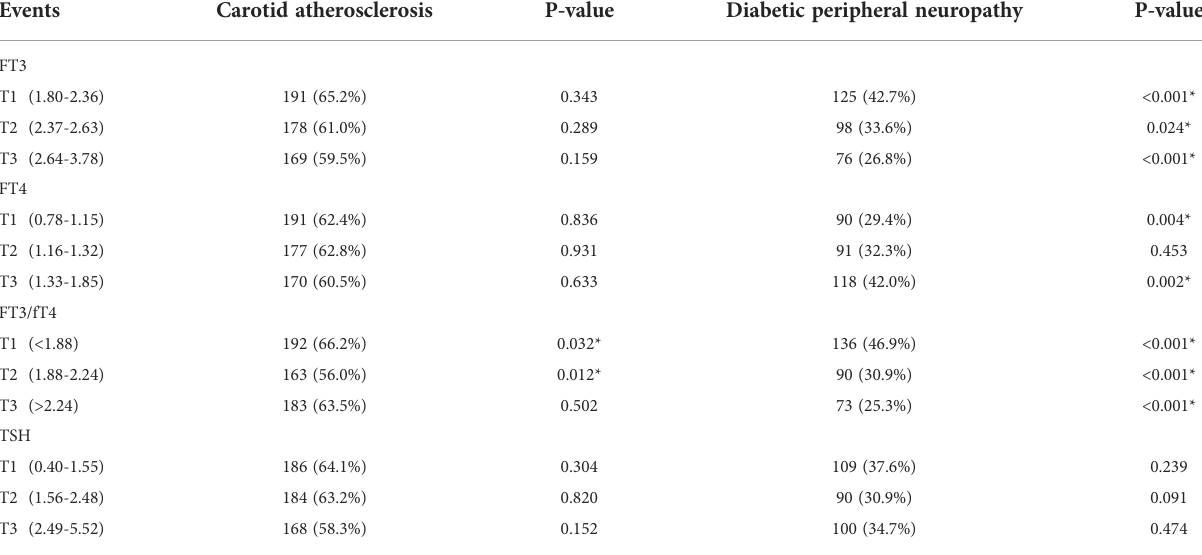
TABLE 2 Prevalence of CA and DPN in different thyroid-related hormones tertiles. Events